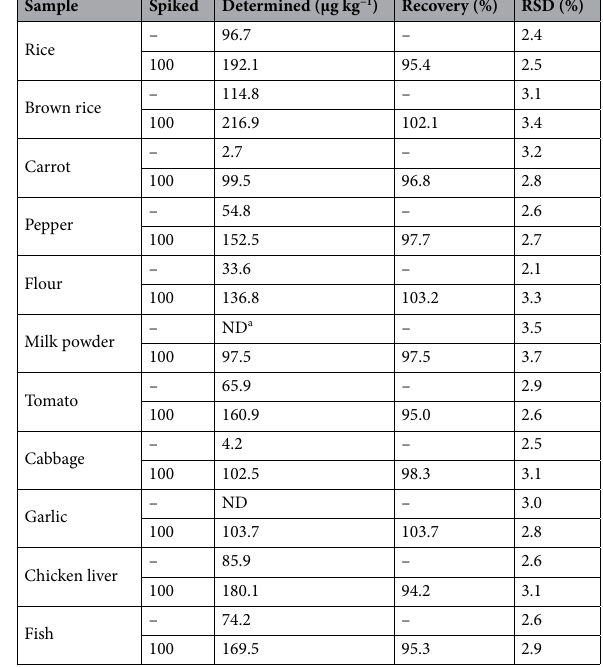
Table 7 . Results of HGAAS analysis of food samples spiked with known amounts of As(III). a Not determined.